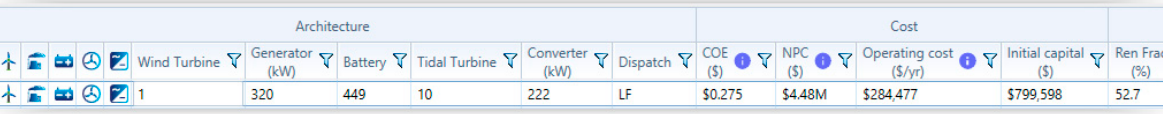
Table 11. Mean output for different scenarios.